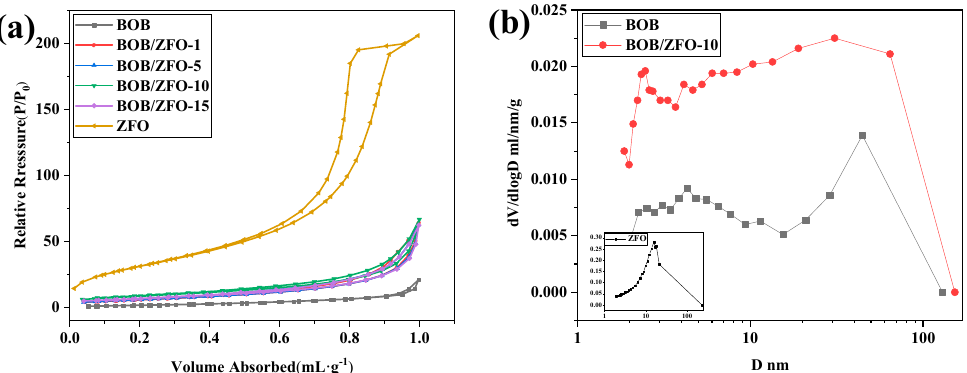
Figure 4. ( a ) Nitrogen adsorption–desorption isotherm and ( b ) the corresponding BJH pore size distribution of the BiOBr, ZnFe 2 O 4 and BOB/ZFO-x composites.